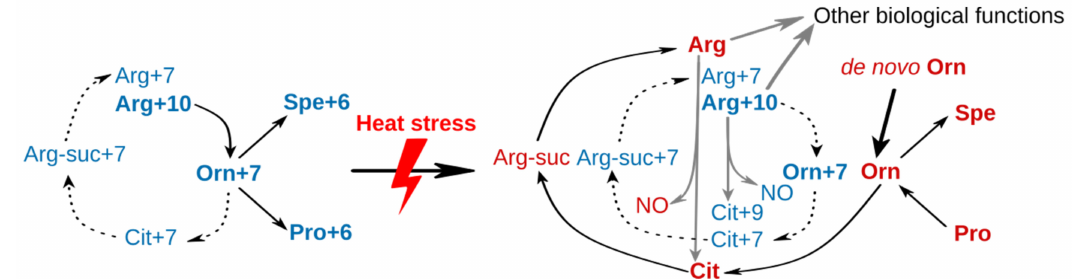
Figure 7. Remodeling of arginine metabolism pathway of yeast Saccharomyces cerevisiae upon heat stress. All labeled metabolites are shown in blue, while nonlabeled in red. The detectable metabolites are highlighted in bold text. Black arrow indicates the flux of a pathway, while grey arrow a putative pathway. Dash arrows indicate inactive